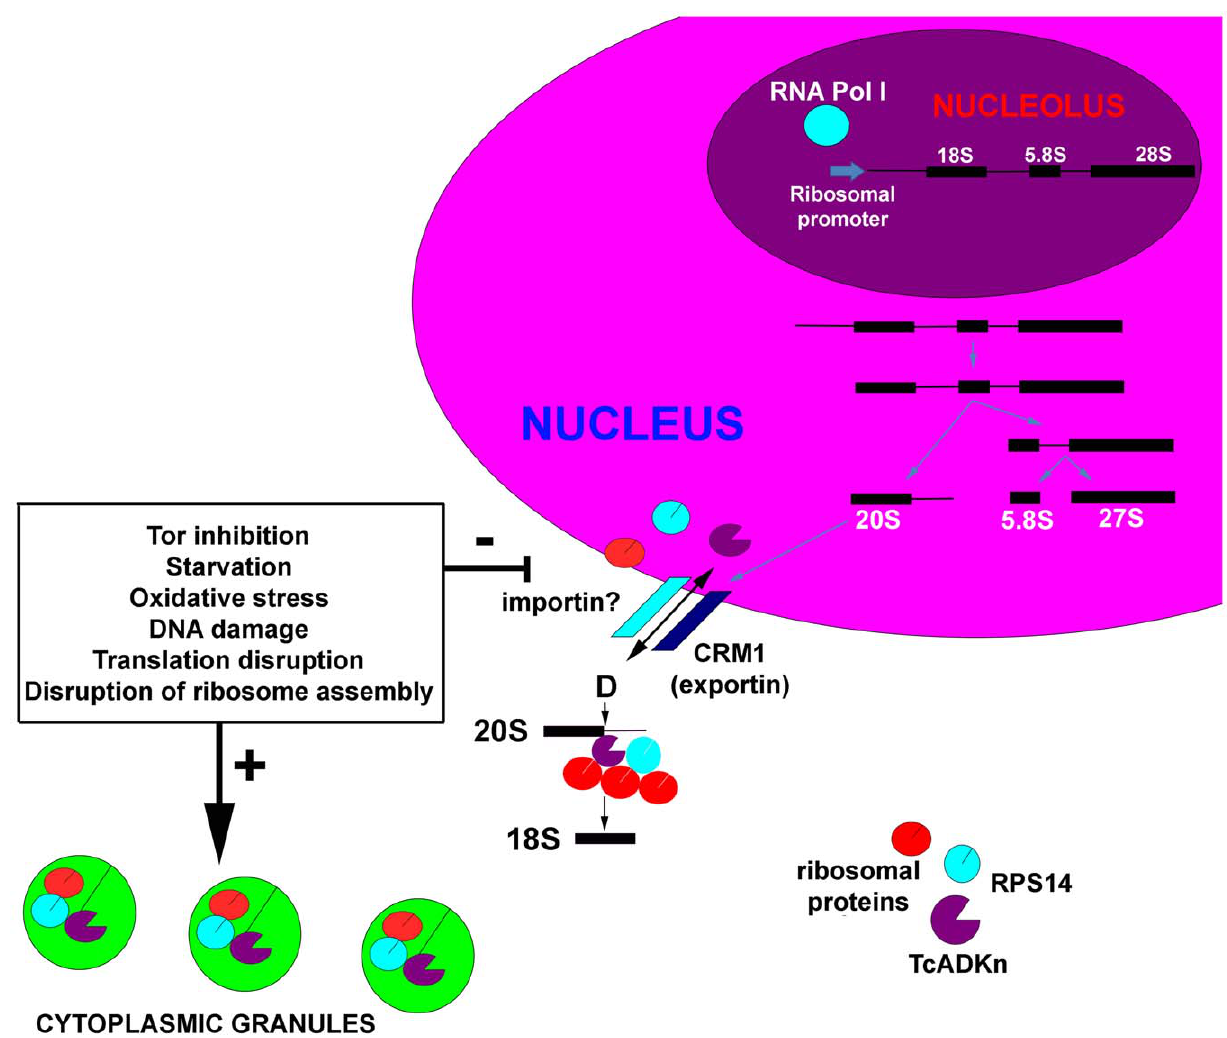
Figure 7. Model proposed for TcADKn function and regulation. TcADKn is involved in ribosome biogenesis, being involved in the processing of the 18S precursor at site D by directly interacting with TcRps14. TcADKn would be regulated by nutrient availability, ribosome activity, active transcription and the TOR pathway. The scheme represents a putative dynamic model for the role of TcADKn on ribosome biogenesis and its regulation.